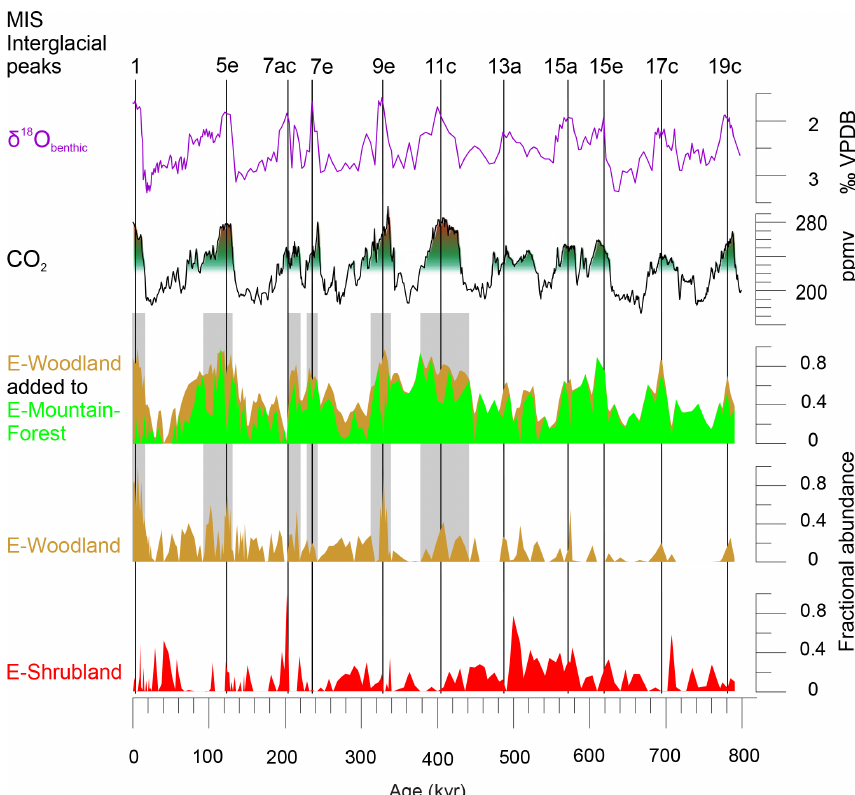
Figure 4. Comparing pollen assemblages E-Mountain-Forest, E-Woodland and E-Shrubland with atmospheric CO 2 (Bereiter et al., 2015; PAGES, 2016). On top are denoted interglacial peaks of the past 800kyr (PAGES, 2016) and stable oxygen isotopes of benthic foraminifera ( δ 18 O benthic ) of MD96-2048 (Caley et al., 2018b). CO 2 levels of 220 and 270ppmv are indicated with green–red shading. Grey shading highlights periods with maximum atmospheric CO 2 and maximum values of the sum of E-Woodland and E-Mountain-Forest. VPDB: Vienna Pee Dee